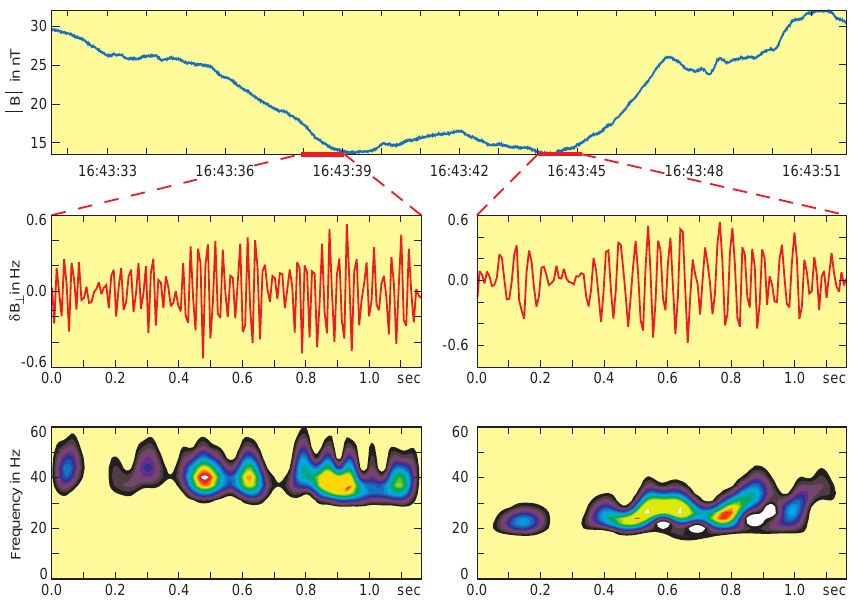
Fig. 2. Mirror mode trough, embedded lion roar wave forms, and right-hand polarized wavelet spectrograms